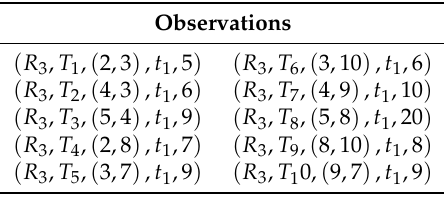
Figure 4. ( a ) Distribution of tags detected by R 3 and ( b ) readings of tags by reader R 3 . Table 1. Readings of tags by reader R 3